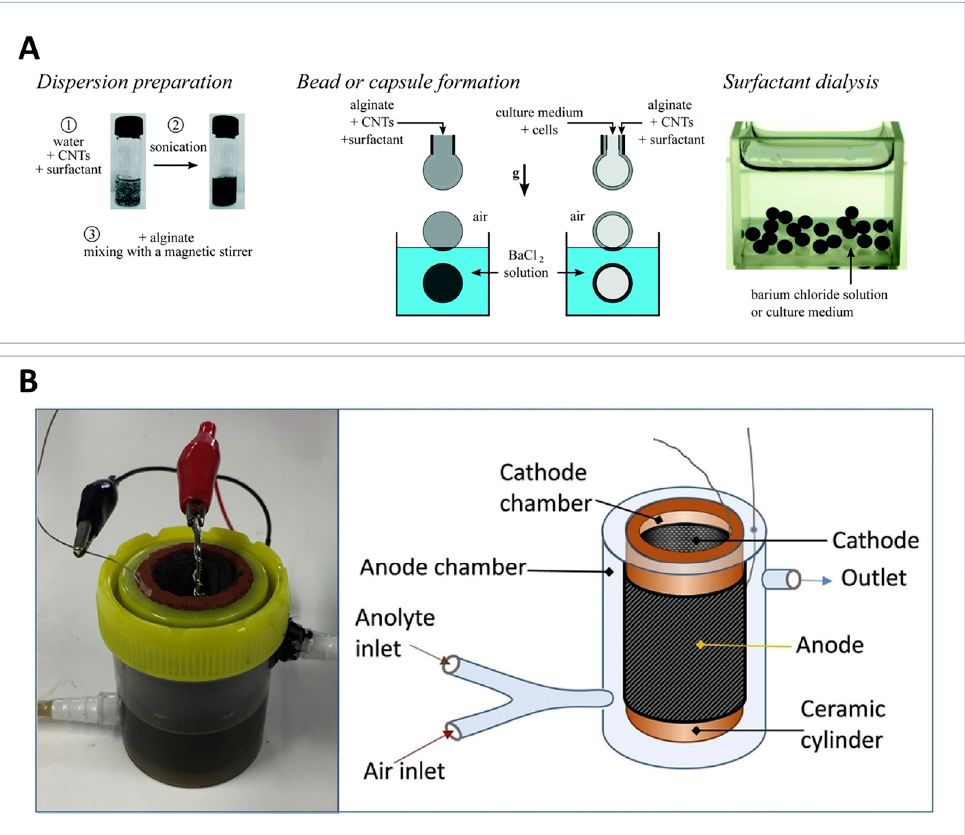
Figure 6. Examples of hydrogel based MFCs used in sensor applications. ( A ) Encapsulation of microbes in alginate/CNT hydrogel beads for the probing of microbial activity [174]; ( B ) ceramic MFC containing a catholyte expanding hydrogel, improving the contact between the cathode and the ceramic [175].